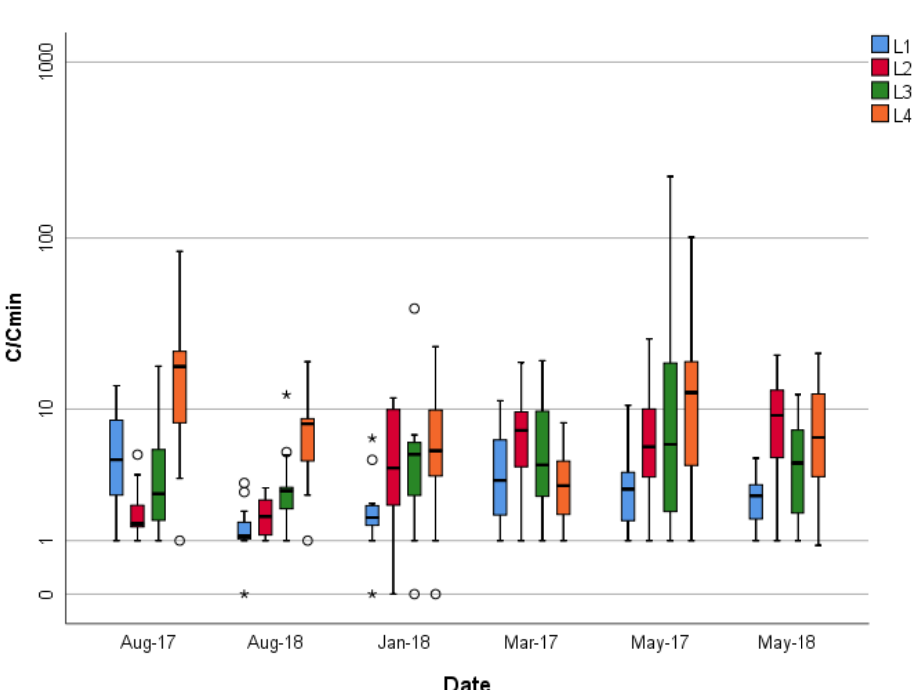
Figure 5. A series of box plots demonstrating the ratio of the minimum concentration to each corresponding concentration for the respective 14 d sampling event. The ratio was determined for each of the 24 sampling events. The x-axis represents the dates and locations of the sampling events; the y-axis is the ratio of the lowest concentration to each respective concentration for a specific date and location. Note: the center lines are the medians, the bottom and top of the boxes are the 25th and 75th percentiles, the whiskers are the 95th percentile, circles are between 1.5 and 3.0 of the interquartile (IQR) lines, and the asterisks are extreme values greater than 3 IQRs. Not all datasets have values above 1.5 IQR.